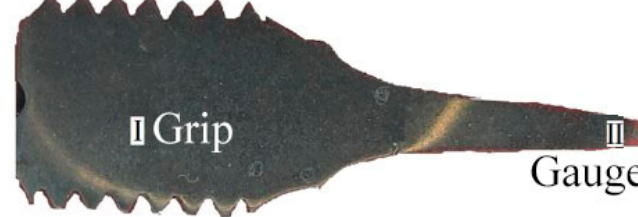
Figure 2. Slice from the ruptured sample.